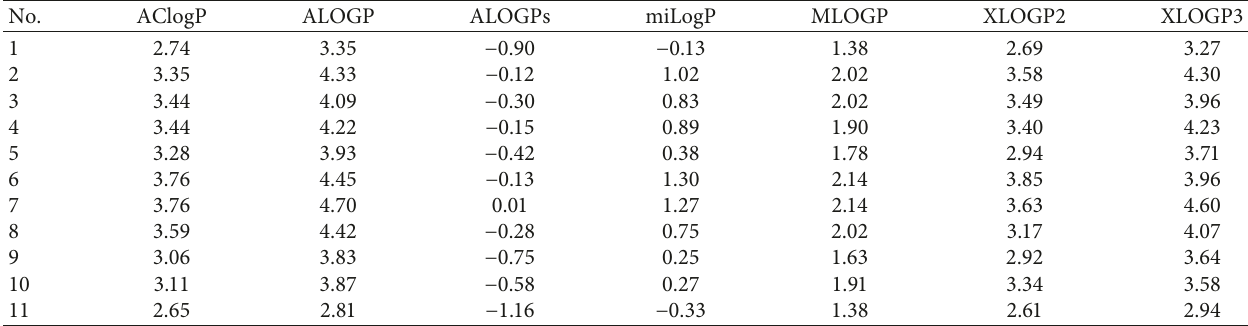
Table 4: Correlation equations for relationships between R